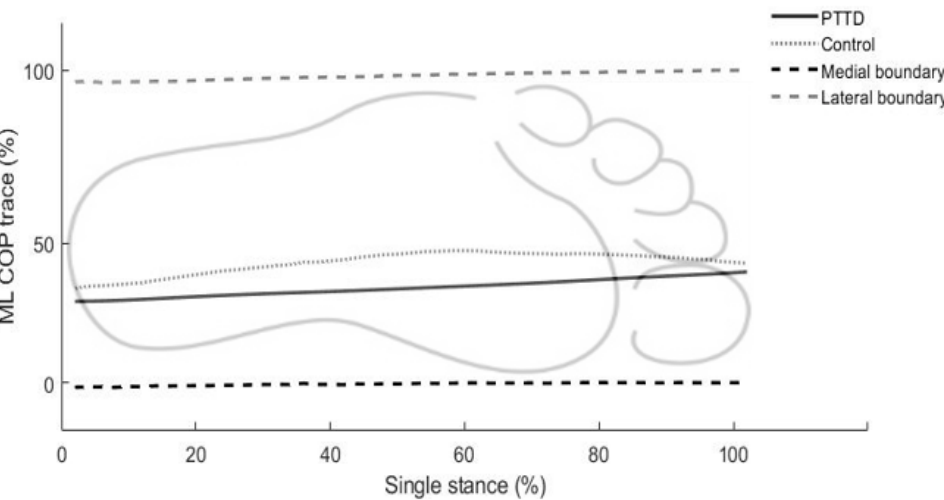
Figure 3. Illustration of normalized COP trace relative to the medial-lateral boundary of the foot: 0% of the COP trace indicates that COP is close to the medial boundary, 100% indicates COP is close to the lateral boundary, and 50% indicates COP is in the middle of the medial-lateral boundary.